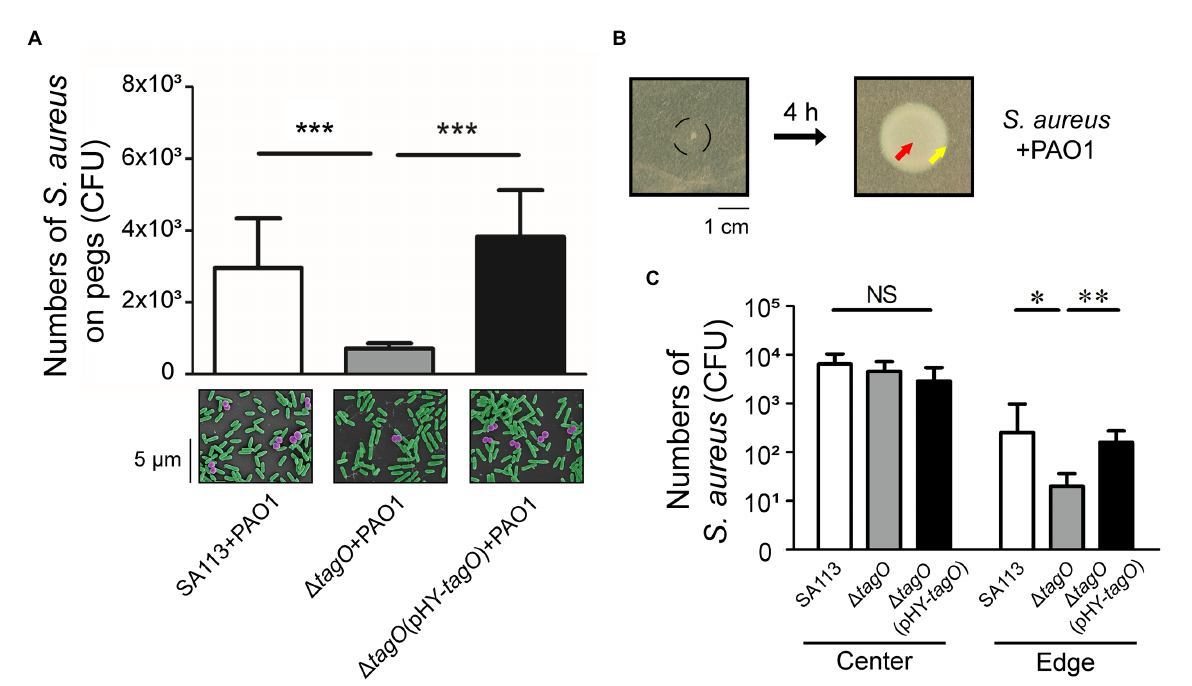
FIGURE 2 Influence of WTA in the hitchhiking motility of Staphylococcus aureus . (A) Staphylococcus aureus SA113, Δ tagO mutant of S. aureus SA113, and the mutant transformed with pHY-tagO were mixed with Pseudomonas aeruginosa PAO1 and added into wells of CBD plates. The number of S. aureus adhered on pegs was determined. The lower panel shows SEM images of S. aureus (purple) associated with P. aeruginosa (green) on pegs. The images shown are representative of three independent experiments. (B) Staphylococcus aureus was mixed with P. aeruginosa and inoculated on TSA-0.4 plates. The black circle indicates the area of inoculation (left panel). The plates were incubated for 4 h to allow bacteria to swarm. (C) Staphylococcus aureus located at the center (red arrow) and the edge (yellow arrow) of the swarm were collected using a toothpick. Bacteria on the toothpick were suspended in PBS and plated on mannitol salt agar for viable cell counts. Data are presented as the mean of the results from more than three independent experiments. Data were analyzed statistically using One-way ANOVA. Error bars indicate the standard deviations. Significant differences are denoted as follows: * indicates p < 0.05, ** indicates p < 0.01, and *** indicates p < 0.001. NS, no